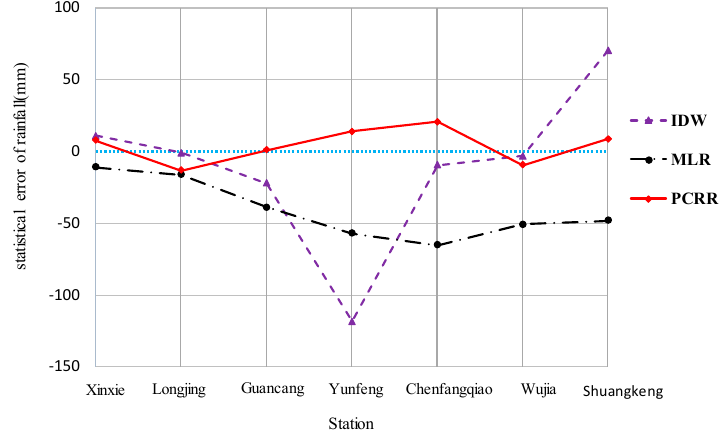
Figure 3. Statistical error of rainfall between interpolation methods and meteorological station rainfall measurements in the basin.